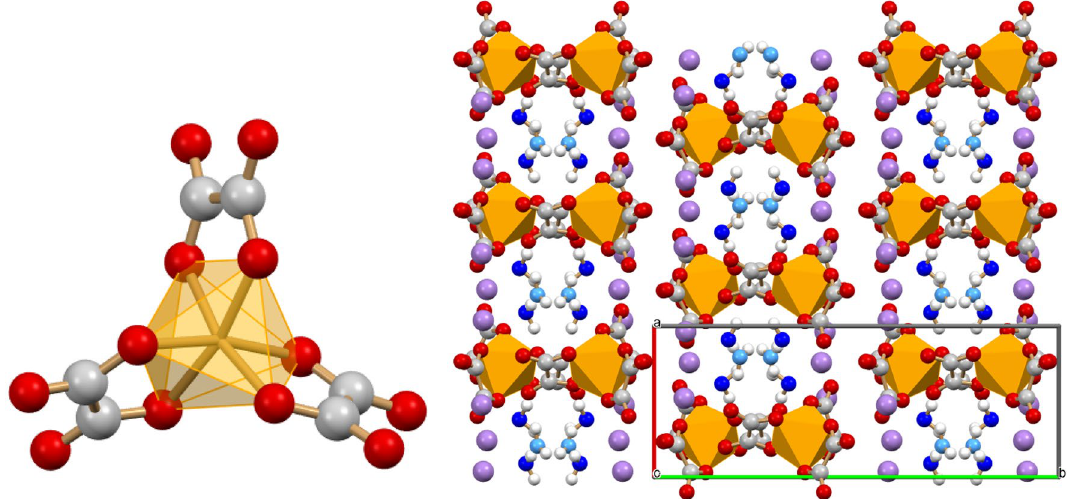
Figure 3. (Left) The structure of the [Ga(ox) 3 ] 3− complex; (right) the channels accommodating the water molecules in the crystal structure of K 3 [Ga(ox) 3 ]·3H 2 O. K + in violet, O W atoms in blue and